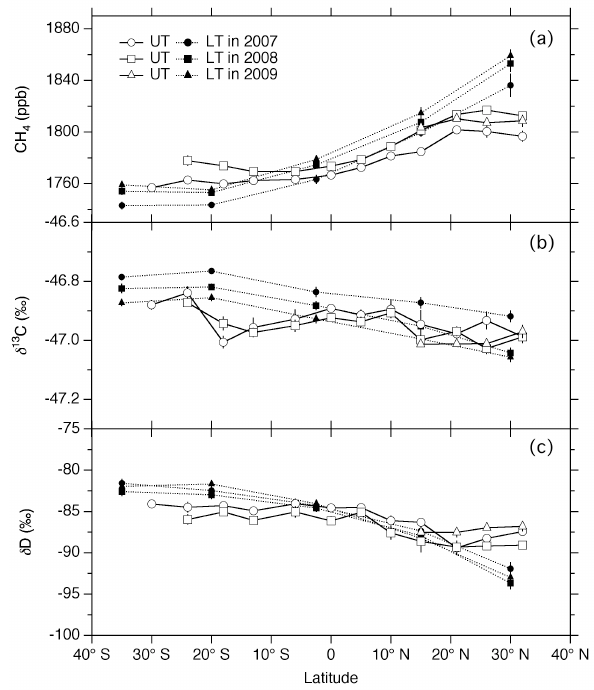
Figure 5. Latitudinal distributions of annual averages of (a) the CH 4 mixing ratio, (b) δ 13 C and (c) δ D in the UT (open symbols with solid lines) and LT (closed symbols with dotted lines). Each error bar represents one standard error of the data deviations from the best-fit curves.